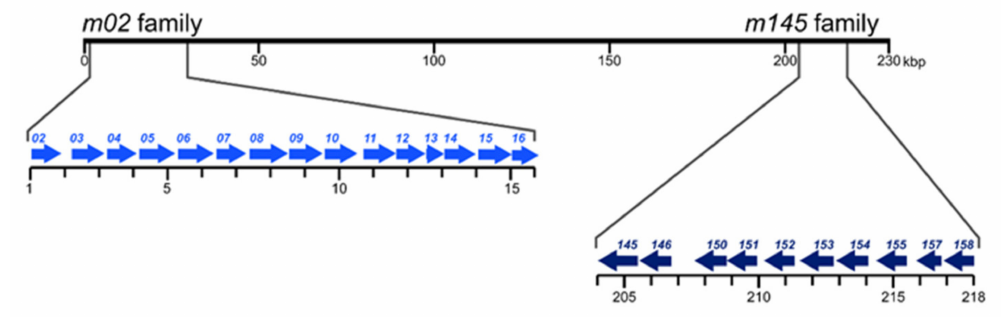
Figure 1. Map positions of mCMV gene families m02 and m145 . Arrows indicate the direction of transcription on the coding DNA strand [20,21]. In mCMV gene nomenclature, lower case “ m ” indicates an absence of homology to hCMV